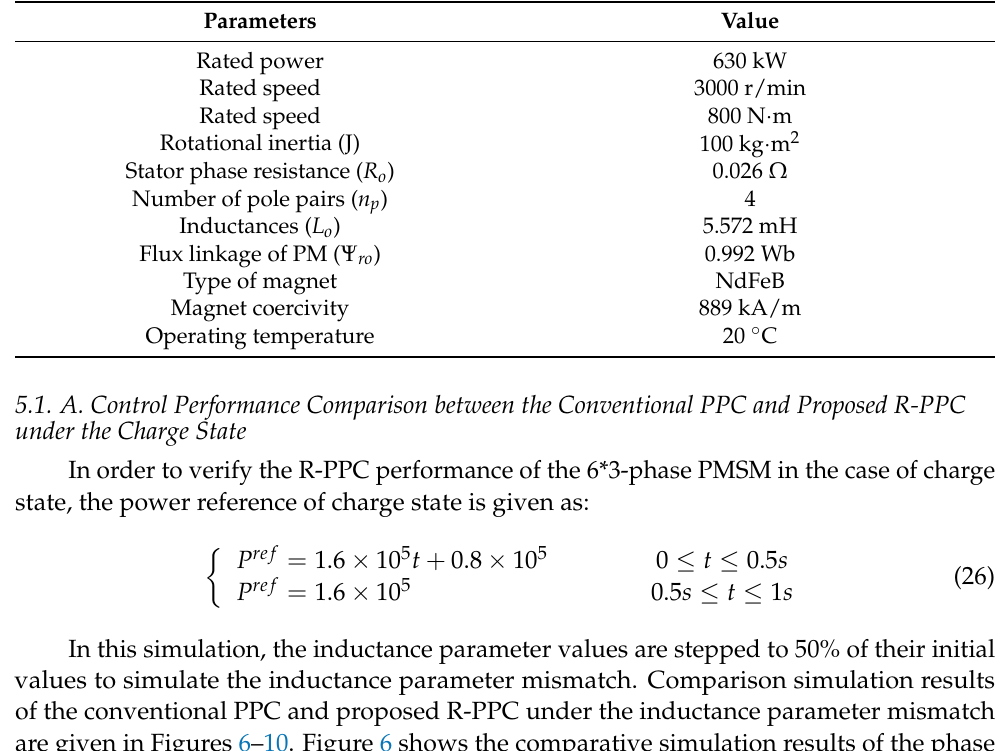
Table 1. 6*3-phase PMSM.